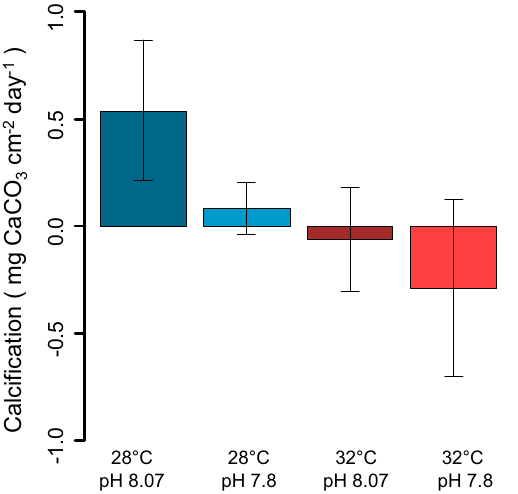
Figure 5. Calcification rate of Neogoniolithon brassica-florida after 64 days under different treatments. Error bars show the confidence